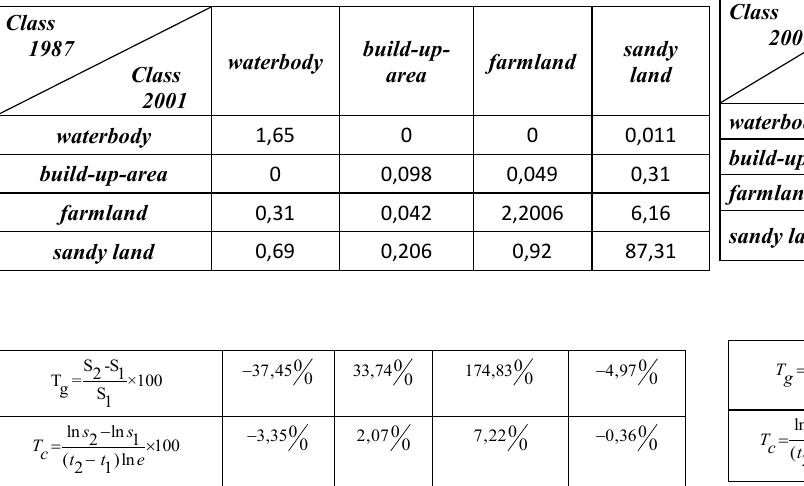
Table 2: Quantitative evaluation of land use changes during the period from 2001 to